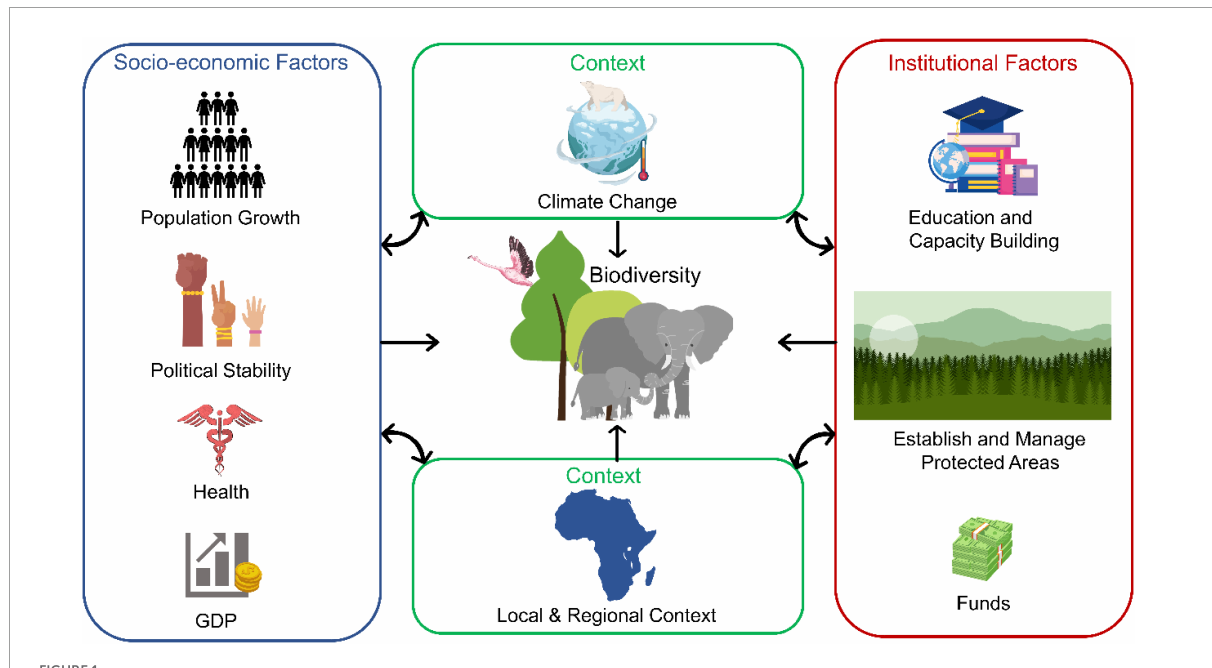
FIGURE1 A conceptual framework that integrates threats, context, and the factors that must be considered if Africa’s biodiversity is to persist and be effectively